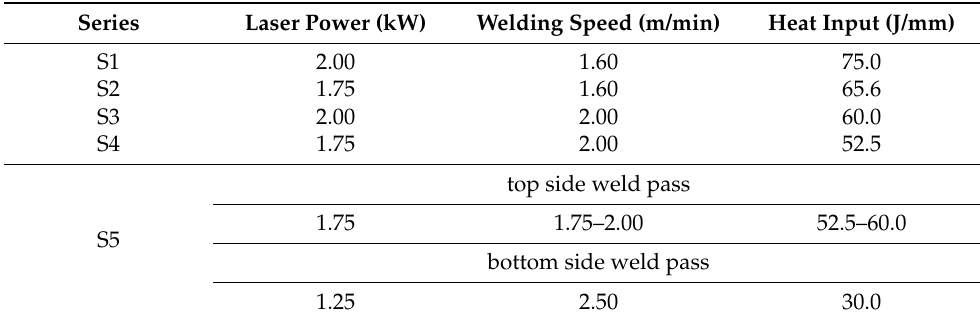
Table 2. Welding parameters used in the experimental